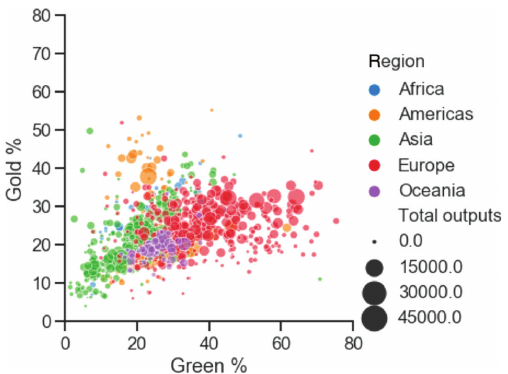
Fig. 7: Global percentages of green versus gold OA publications by region, 2017. Data collected by Curtin Open Knowledge Initiative,